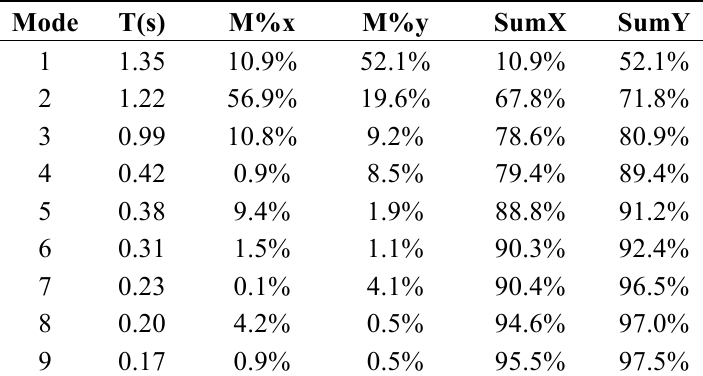
Table 1. Modal properties for the Benchmark